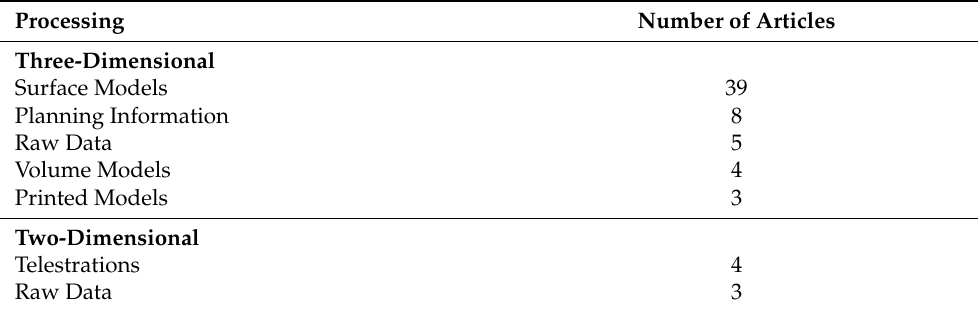
Table 3. Papers categorized by the data processing type used. Some articles included a combination of processing types, such as volume and surface rendered